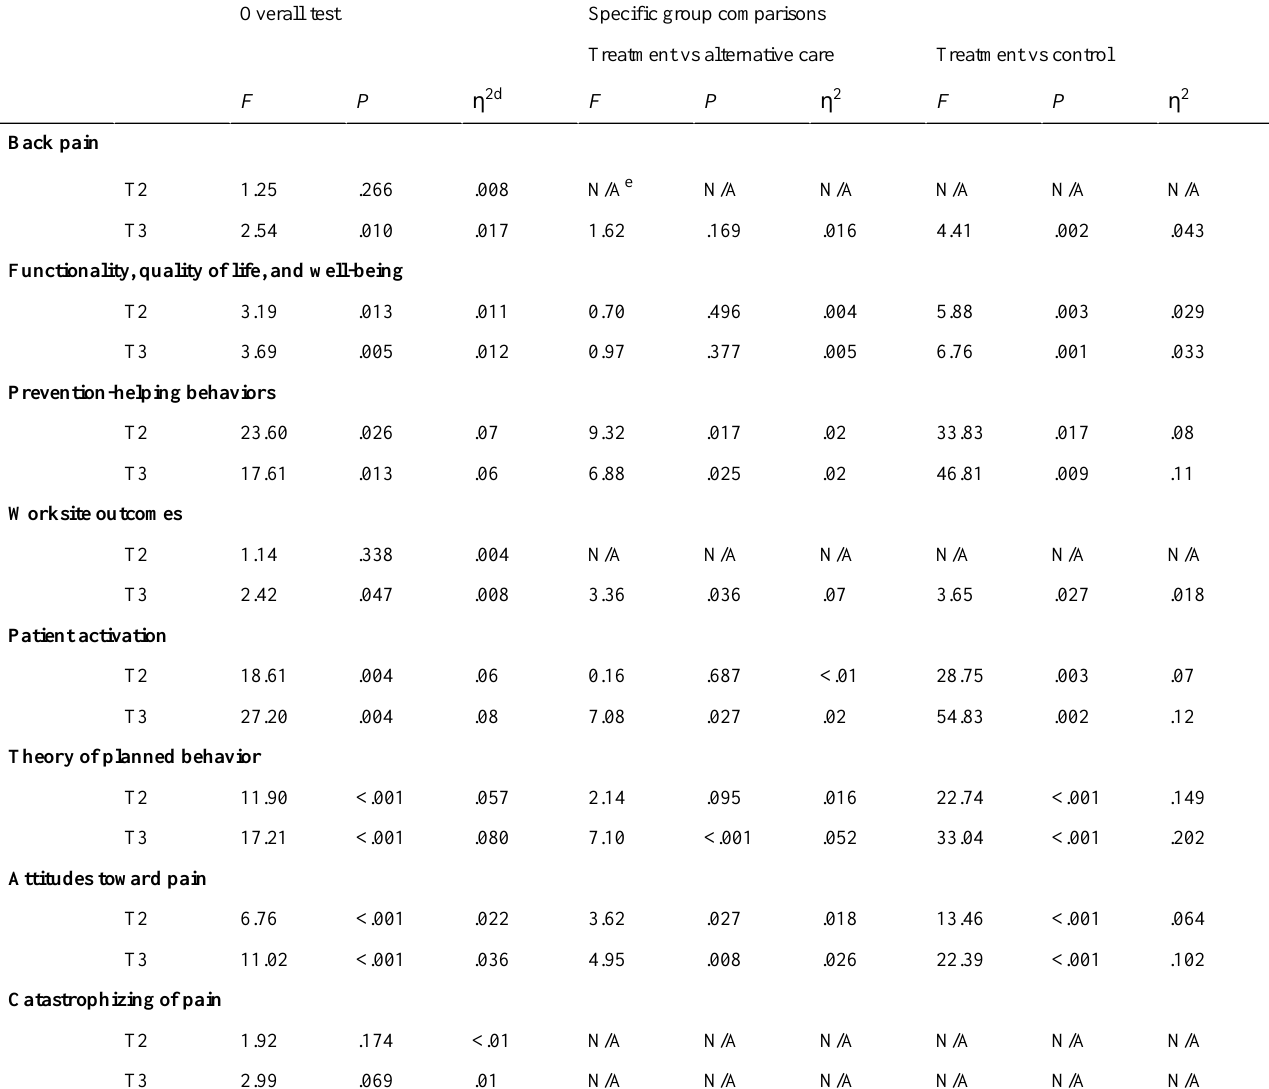
Table 4. Results of multivariate/univariate analysis of covariance models testing for group differences a at T2 b and T3 c .